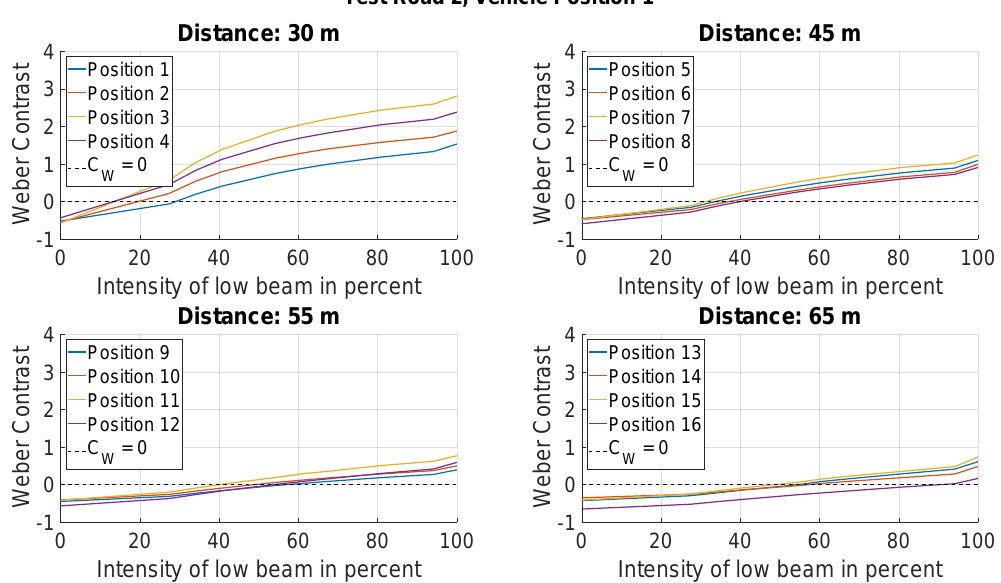
Figure 7. Contrast curves on test road 2 (0.53cdm − 2 ) and vehicle position 1 depending on the intensity percentage from 0% (low beam off) to 100% (low beam fully switched